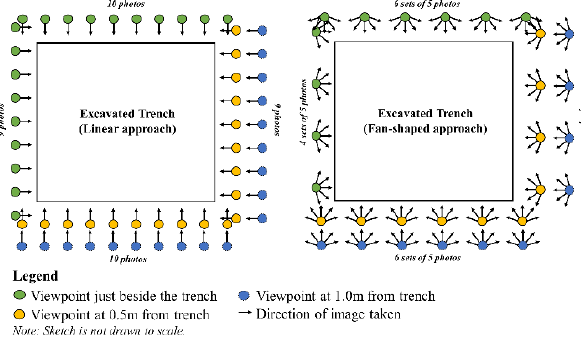
Figure 4 . Geometry of image